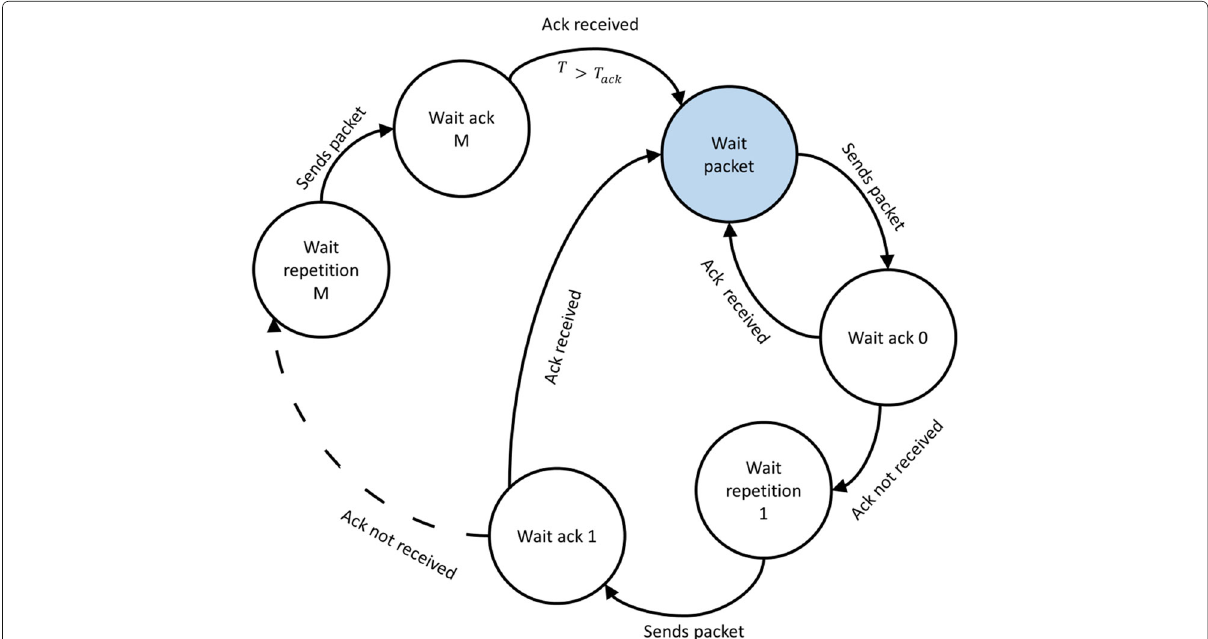
Fig. 4 End-devices